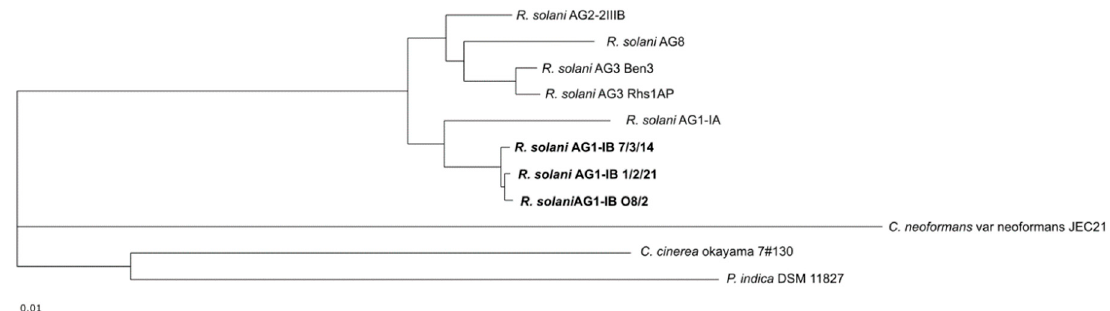
Figure 3. Phylogenetic differentiation of the different R. solani AG1-IB isolates. The phylogenetic tree is based on all core genes (473) of the selected strains as determined by means of the comparative genomics tool EDGAR 3.0. The corresponding tree was calculated within EDGAR. It includes R. solani AG1-IB (isolates 7/3/14, O8/2, 1/2/21), R. solani AG1-IA (isolate B275), R. solani AG3 (isolates Rhs1AP, Ben3), R. solani AG8 (isolate WAC10335), R. solani AG2-2IIIB (isolate BBA 6967), C. cinerea okayama 7#130, P. indica DSM 11827 and C. neoformans var neoformans JEC21. A bootstrap confidence analysis was performed with 1000 replicates to determine the reliability of the tree obtained. All bootstrap values appeared to be 100%.